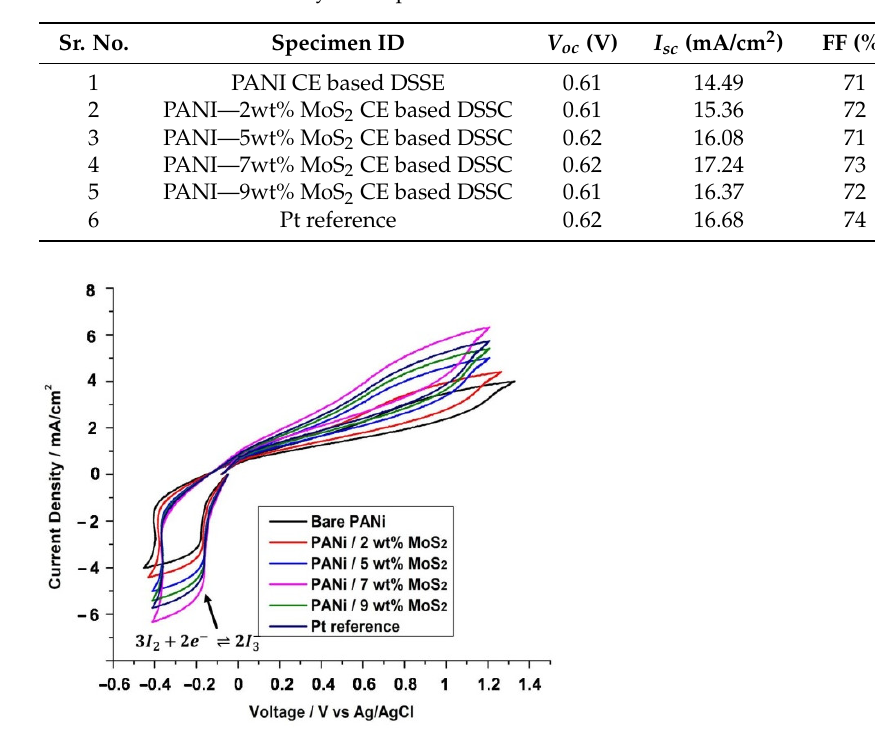
Table 1. A detailed summary of I-V parameters.